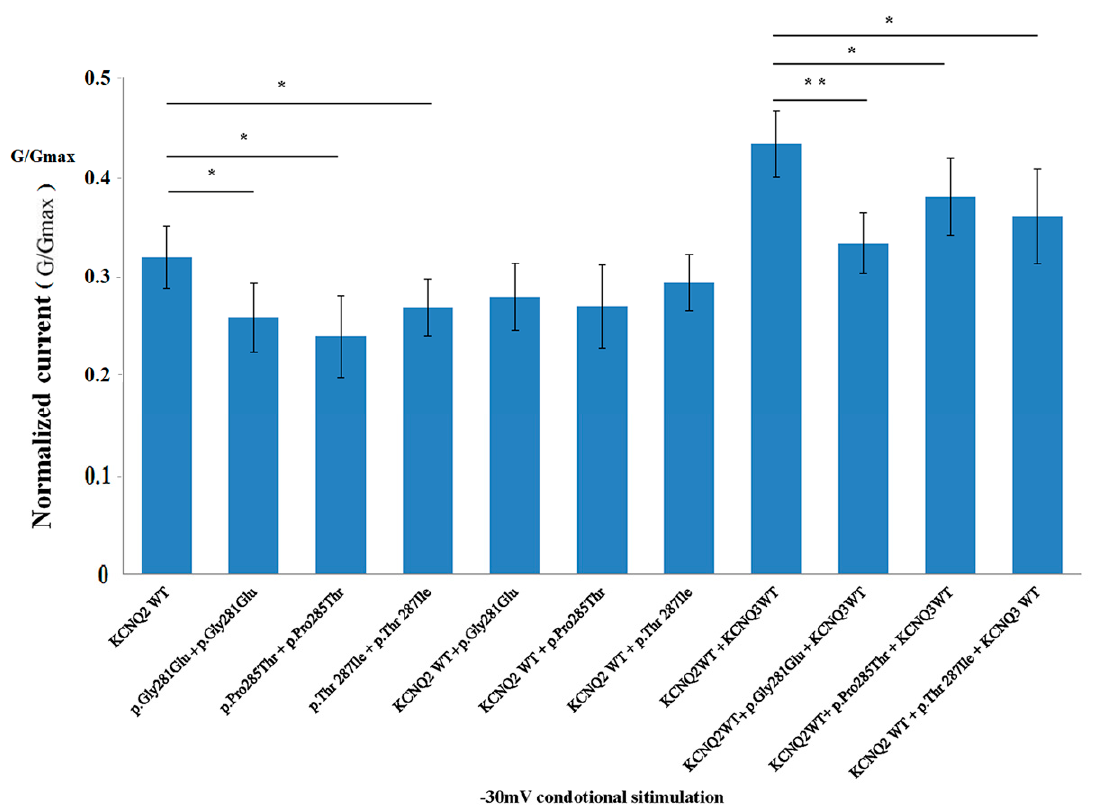
Figure 5. The normalized current in p.Thr287Ile, p.Gly281Glu, p.Pro285Thr and wild type demonstrated the homomerically transfections in 3 mutations that were significant lower than the wild type at − 30 mV stimulations. In heteromerically transfected with KCNQ3 + KCNQ2 + variants, the p.Gly281Glu exhibited lower normalized currents than p.Thr287Ile, p.Pro285Thr and KCNQ3 + KCNQ2 wild type. * indicates p < 0.05; **, p < 0.005. KCNQ2 WT and mutant KCNQ2 alleles were transfected into HEK293 cells in homomeric mutants (2 µ g), heteromeric KCNQ2 + mutants (1 µ g + 1 µ g), and heteromeric KCNQ2 WT + variants + KCNQ3 WT (0.5 µ g:0.5 µ g:1 µ g), respectively.